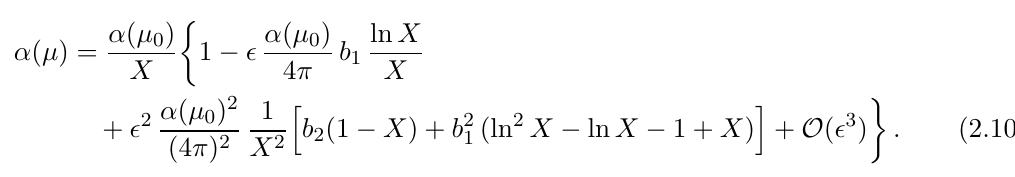
Figure 1 . Relative deviation of the iterative (colored) and expanded solutions (gray) from the exact solution for the running of (cid:11) s ( (cid:22) ) at NLO (dotted), NNLO (dashed), and N 3 LO (solid). Expanding the inverse in eq. (2.9) in (cid:15) , we obtain the expanded NNLO